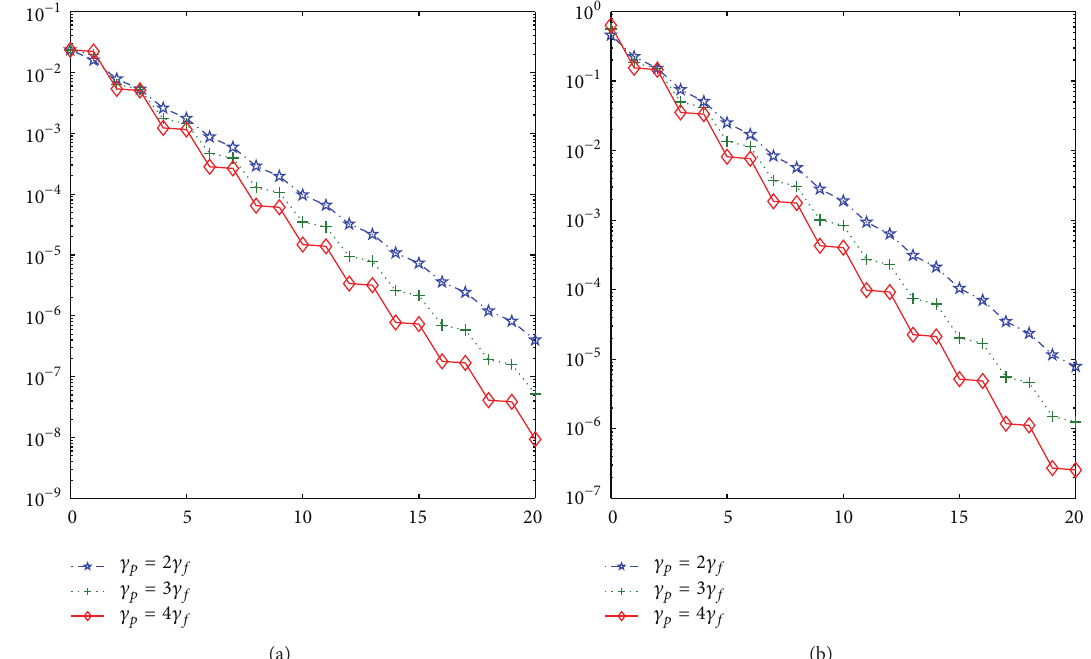
Figure 4: Geometric convergence rate of the velocity of the free flow (a) and the hydraulic head of the porous medium flow (b) for the parallel DDM with BJS interface